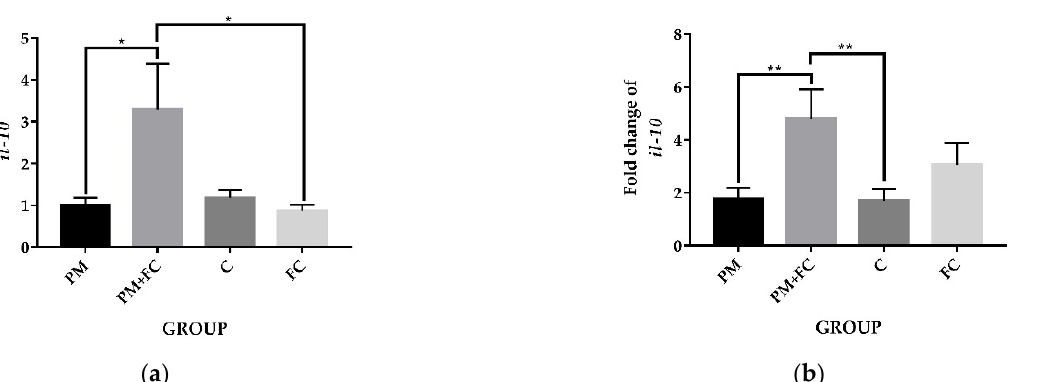
Figure 5. Fold changes of mRNA expression of il-10 in animal tissues.:( a ) mouse lung tissues; ( b ) mouse colon tissues. * p < 0.05, ** p < 0.01.